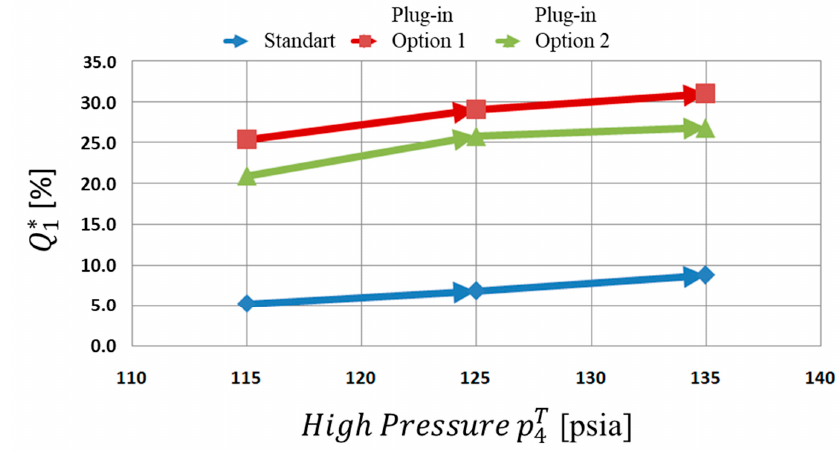
Figure 17. Nondimensional Flow Rate in the loop using a Jet Pump.